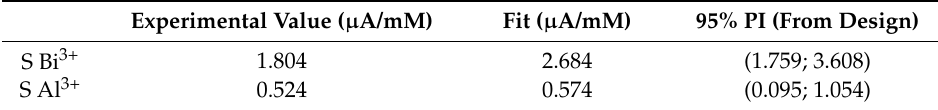
Table 2. Optimal and laboratory experiment